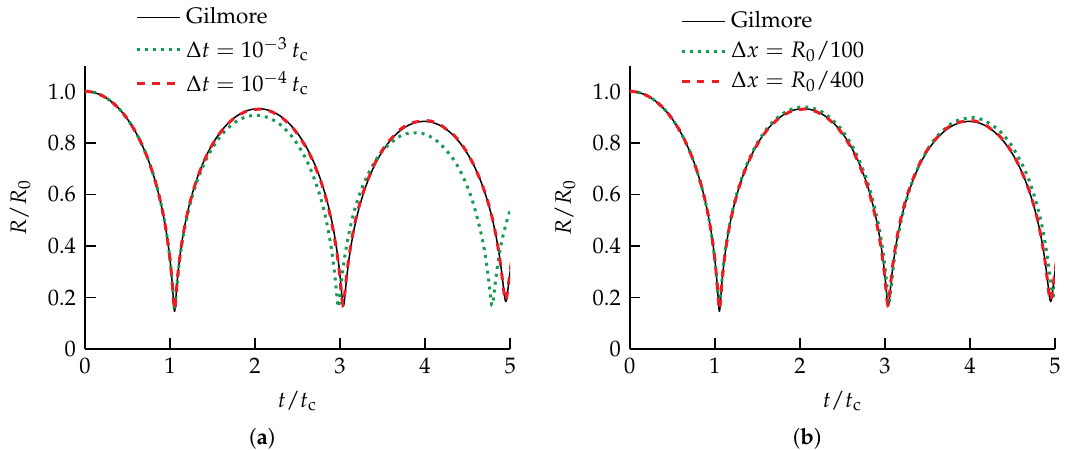
Figure 4. Rayleigh collapse of a spherical bubble. Dimensionless radius R / R 0 as a function of dimensionless time t / t c , where R 0 is the initial radius and t c = 0.915 R 0 collapse time, computed using ( a ) different time-steps ∆ t on a mesh with ∆ x = R 0 /400 and ( b ) on meshes with different mesh spacings ∆ x and a time-step of ∆ t = 10 − 4 t c , compared against the solution of the Gilmore model [9].